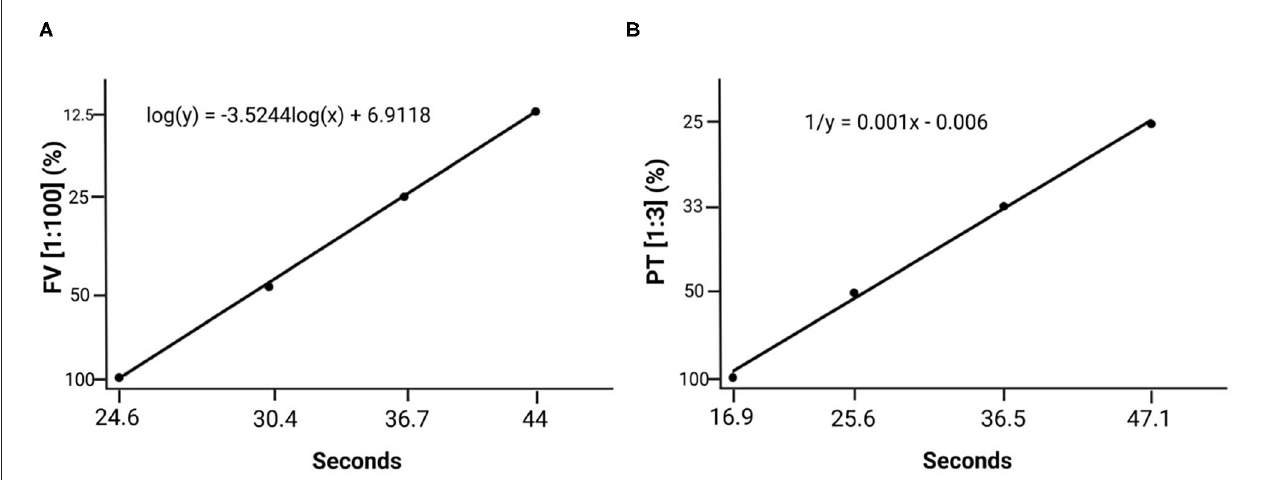
FIGURE 4 | Standard calibration curves created based on the plasma superpool prepared with plasma from all the individuals. (A) Standard factor V curve (1:100 dilution). (B) Standard prothrombin time curve (1:3 dilution).